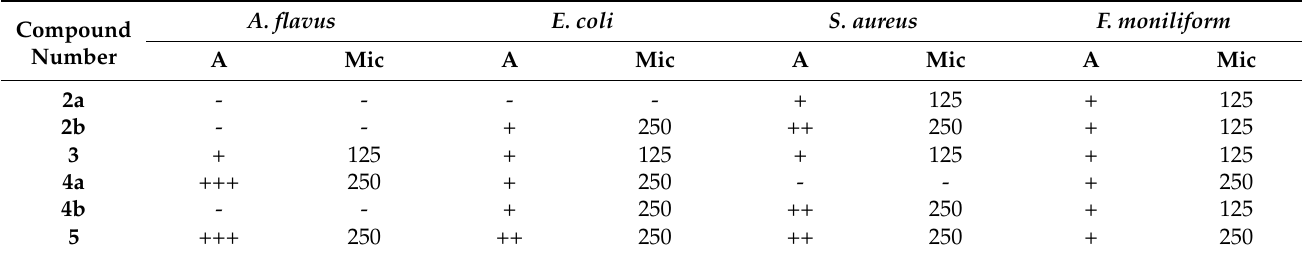
The zone width of inhibition indicates the potency of antimicrobial activity; (-) no activity, (+) mild activity with diameter zone of (0.5–0.7 cm), (++) moderate activity with diameter zone of (1.1–1.2